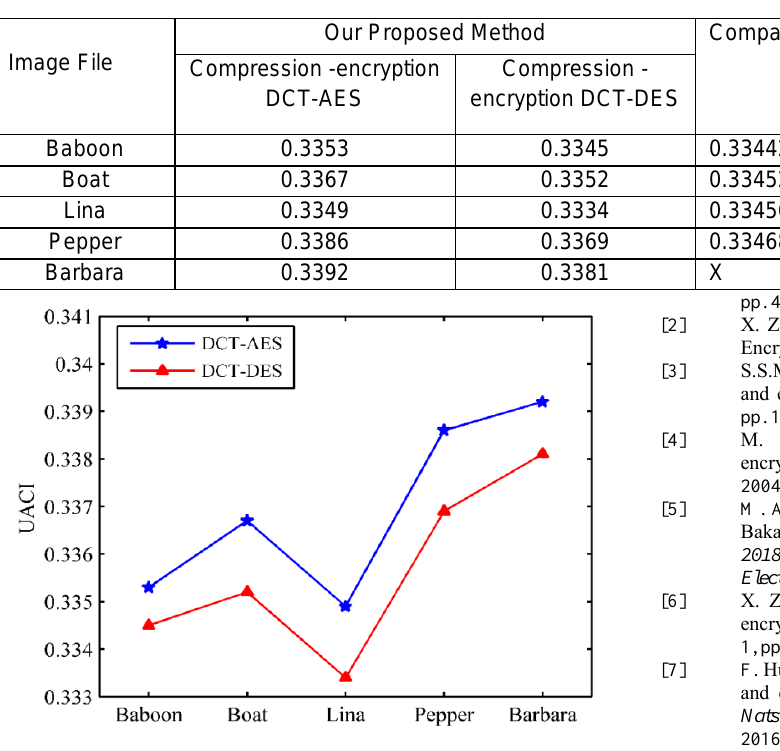
Figure 11 . Graphical representation of comparison of UACI